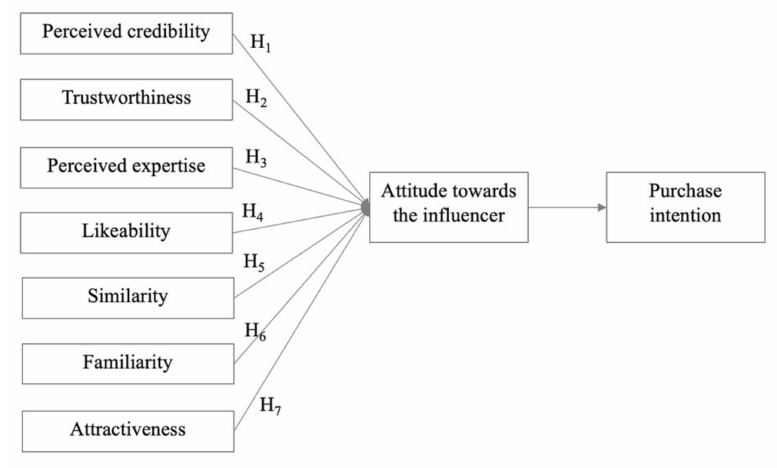
Figure 1. Conceptual model.